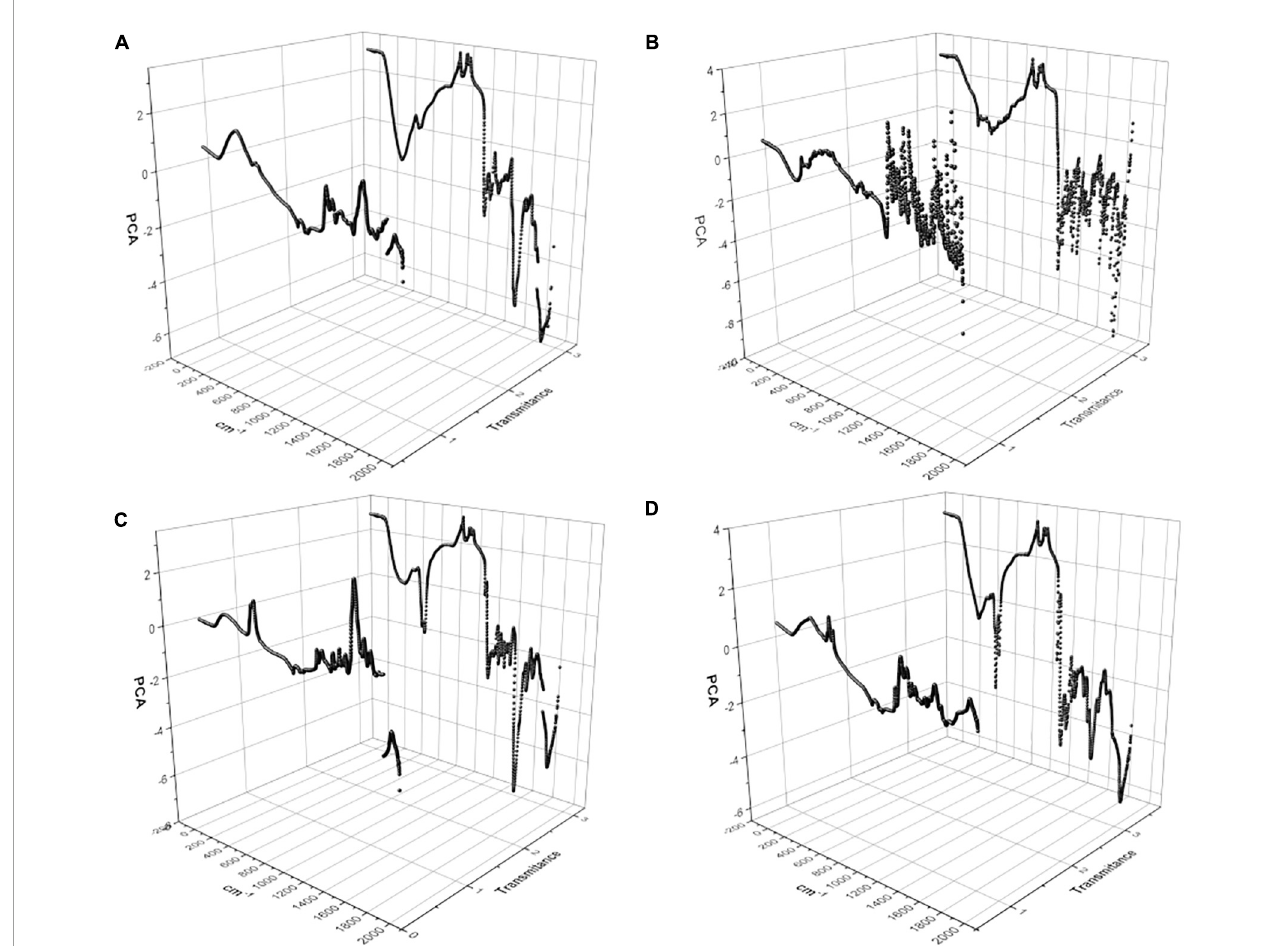
FIGURE10 Principal component analysis (PCA) of the hydrolysis of N. brasiliensis within the calibration curve. Two main components were graphed that expressed the widest variation in the data set, a total of 1932 values given by FT-IR wavelength (X) and transmittance (Y). (A) Casein substrate at 1.25, 2.5, 5, 10, and 20 g, N. brasiliensis and N. brasiliensis + β -HPC. (B) L-Tyrosine substrate at 1.25, 2.5, 5, 10, and 20 g, N. brasiliensis and N. brasiliensis + β -HPC. (C) Tween 80 substrate at 0.1, 0.2, 0.025.0.01, and 0.5%, N. brasiliensis and N. brasiliensis + β -HPC. (D) Egg yolk substrate at 93.75, 187.5, 375, 750, 1500 mL, N. brasiliensis and N. brasiliensis + β -HPC. The PCA analysis was performed with OriginPro 2018 and R Commander